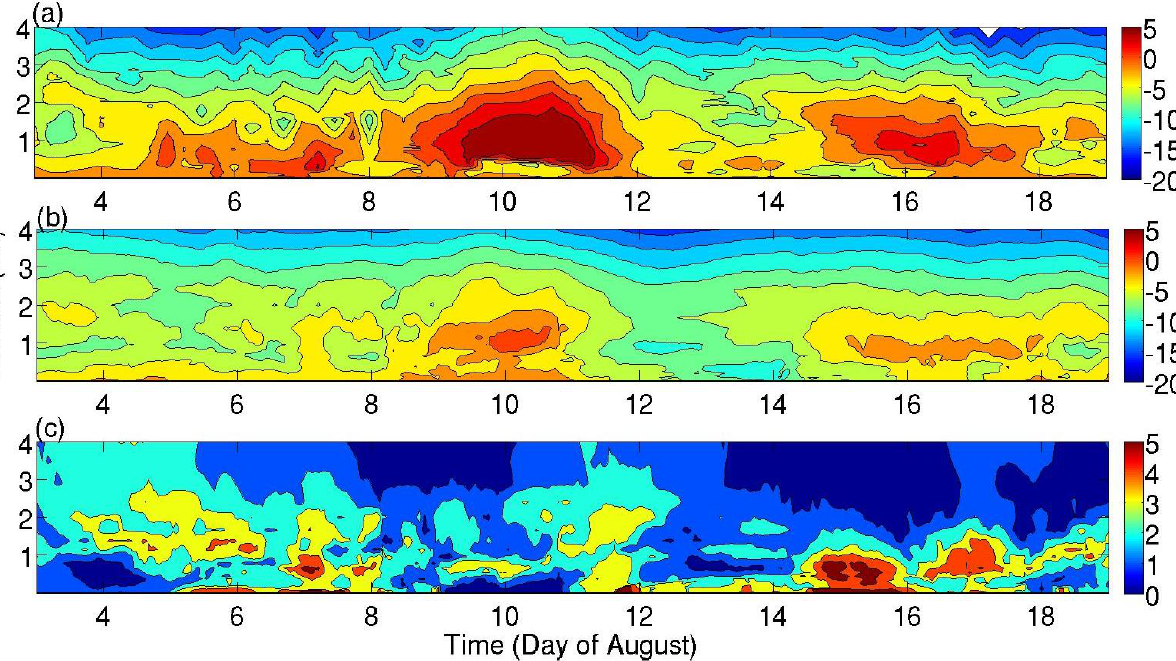
Figure 2. Time-height cross-sections of atmospheric temperature (°C) showing ( a ) observations, the modeled ( b ) ensemble average and ( c ) model ensemble standard deviation. Model ensemble statistics are based on hourly model output while observations were nominally taken